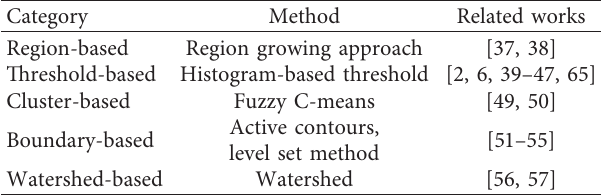
Figure 9: Process of separating the teeth. Table 1: Related works grouped by various categories and